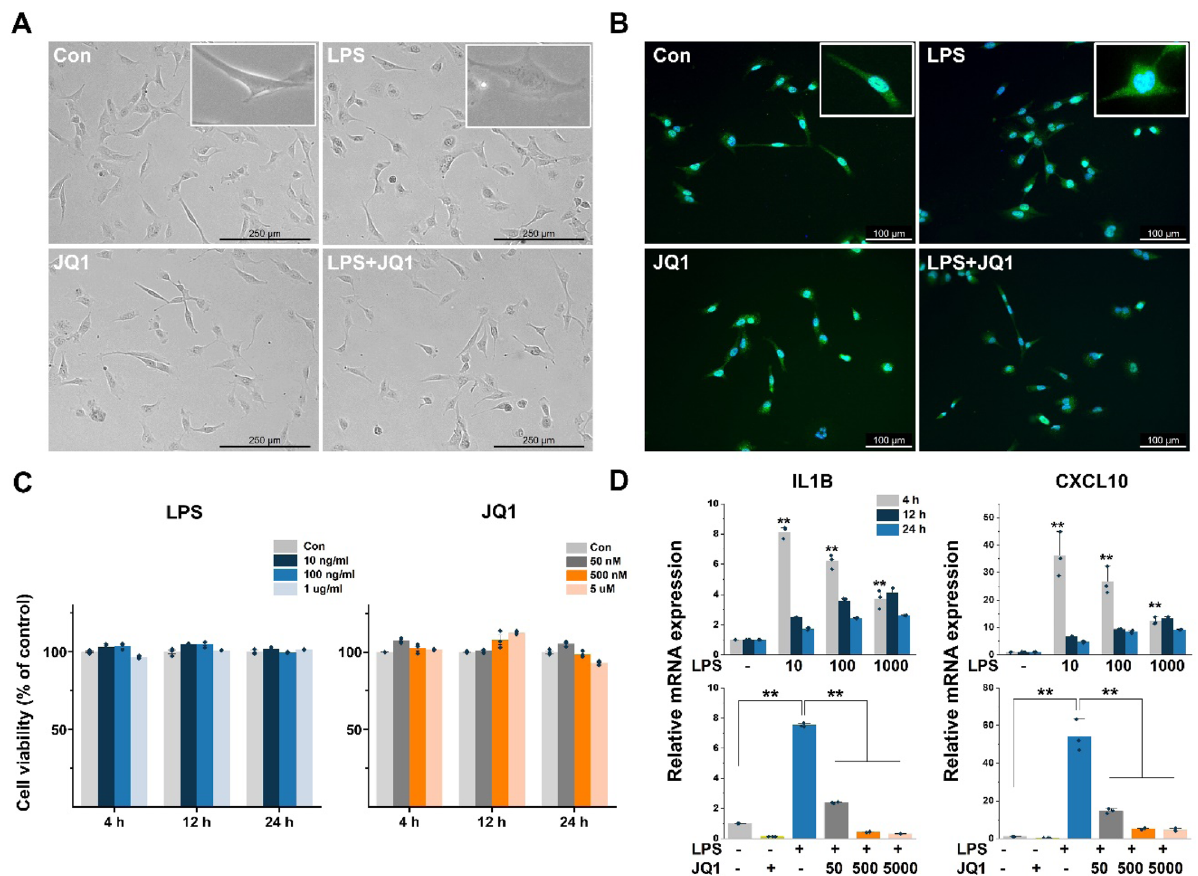
Figure 1. Effects of LPS and JQ1 on HMC3 cells and the expression of inflammatory response-related genes in LPS- and JQ1-treated cells. ( A ) Morphology of HMC3 cells after treatment with LPS, JQ1, and LPS + JQ1 for 4 h. ( B ) HMC3 cells were cultured for 4 h after treatment with LPS (100 ng/ml) and JQ1 (500 nM) and stained for IBA1 (green fluorescence), a microglia-lineage marker. Nuclei were counterstained with DAPI (blue). ( C ) HMC3 cells were treated with LPS and JQ1 at different concentrations for different durations (4 h, 24 h, and 48 h). The viability of the HMC3 cells was determined using the WST-1 assay. ( D ) HMC3 cells were treated with LPS at different doses (10, 100, and 1000 ng/ml) for 4 h. Inflammatory genes were significantly upregulated in cells treated with LPS compared to DMSO-treated control cells (upper panel). HMC3 cells were treated with LPS (100 ng/ml) and JQ1 at different doses (50, 500, and 5000 nM) for 4 h. Inflammatory genes were significantly downregulated in cells treated with JQ1 (bottom panel). Gene expression was normalized to GAPDH transcript levels. The data represent three independent experiments. The values are the mean ± SEM of triplicate experiments (* p < 0.05 and ** p < Differentially expressed genes in LPS + JQ1-treated HMC3 cells.